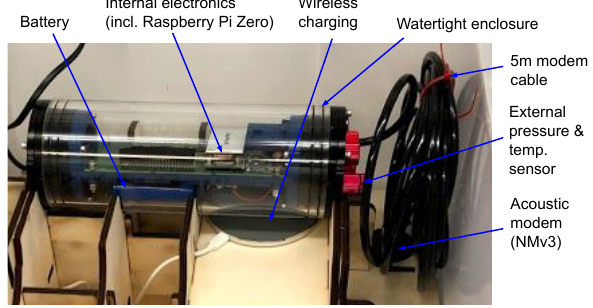
Figure 14. UWA sensor nodes used in the Heslington East lake experiments. The protocol software was implemented in Python 3, both on the Raspberry Pi based sensor nodes and on the laptop gateway